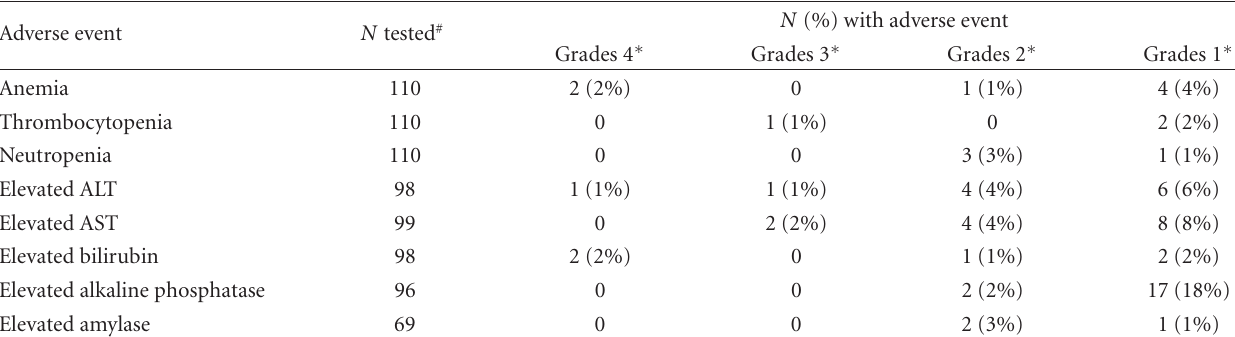
Table 2: Laboratory adverse events.